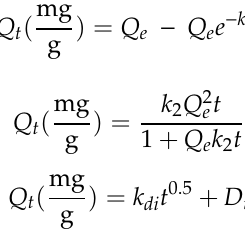
Figure 9. MB adsorption and desorption behaviors on adsorbent over four consecutive cycles.